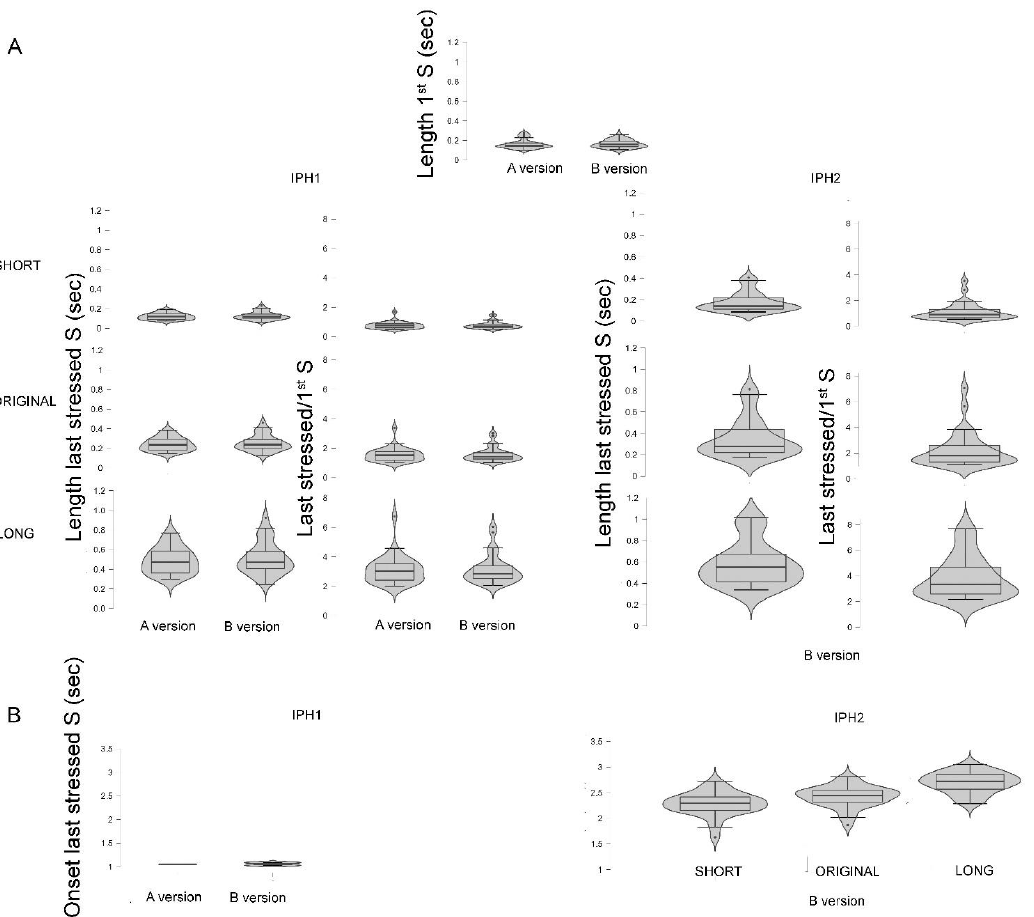
Figure 1. Properties of stimulus materials: ( A ) Length of first syllable (up), length of last stressed syllable and pre-final lengthening (length of last stressed/length of first) for IPH1 (down, left) and IPH 2 (down, right); ( B ) Onset time of last stressed syllable in IPH1 and IPH2. Note: IPH = intonational phrase; though IPH2 was present only in B versions, EEG analyses used B versions onset times in A for comparison between absent ( A ) and present boundary ( B ).